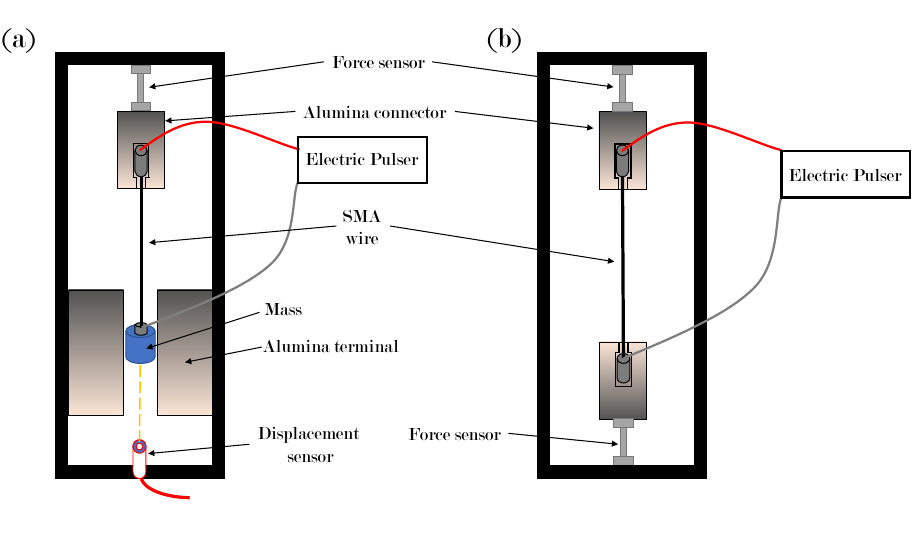
Figure 3. Schematics of the mechanical set-ups of the two experimental configurations: ( a ) clamp-free; ( b )